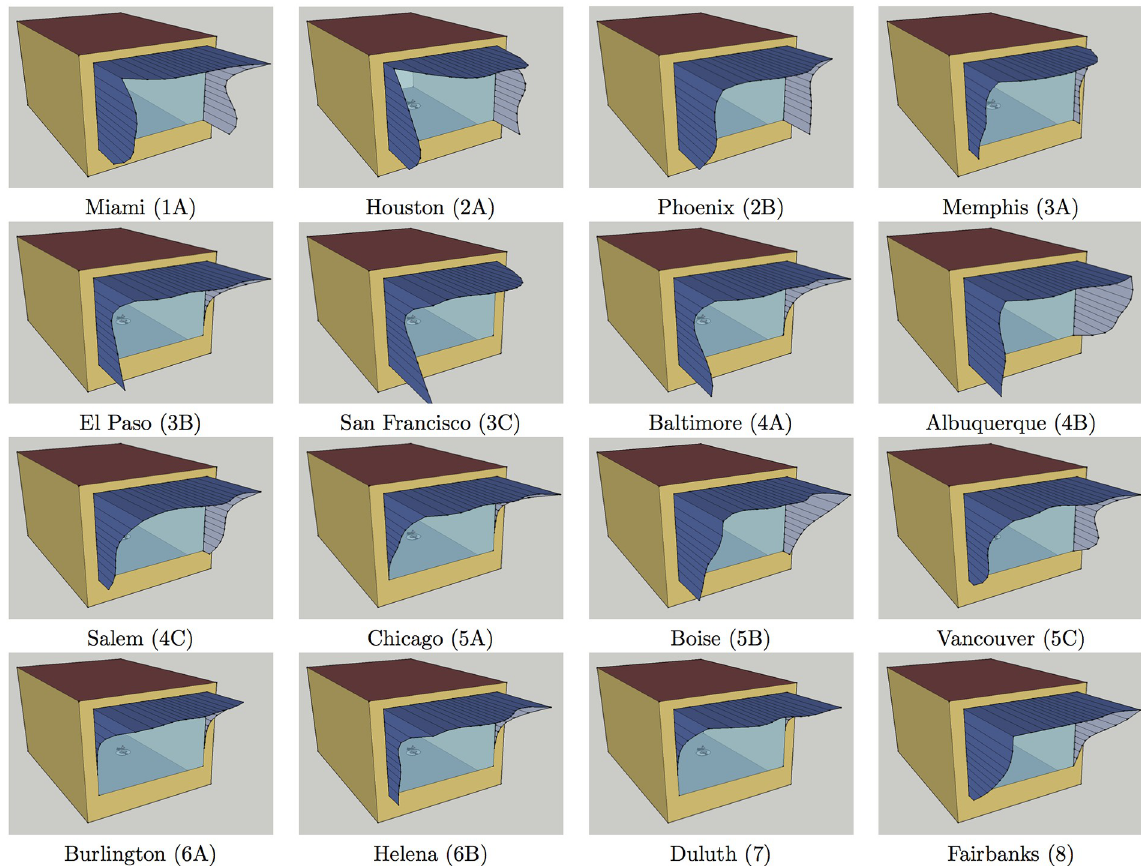
Fig 4. Sketchup visualisations of cellular office model with optimal shading found for each